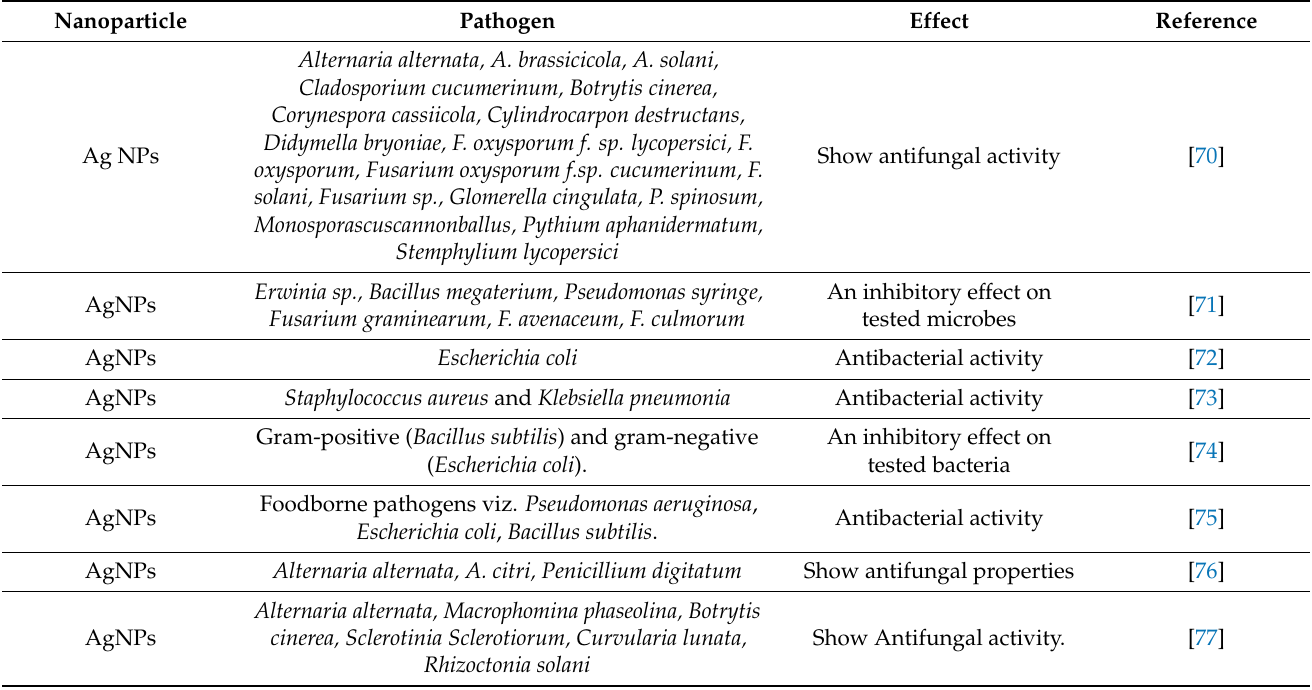
Table 2. Various nanomaterials in plant disease